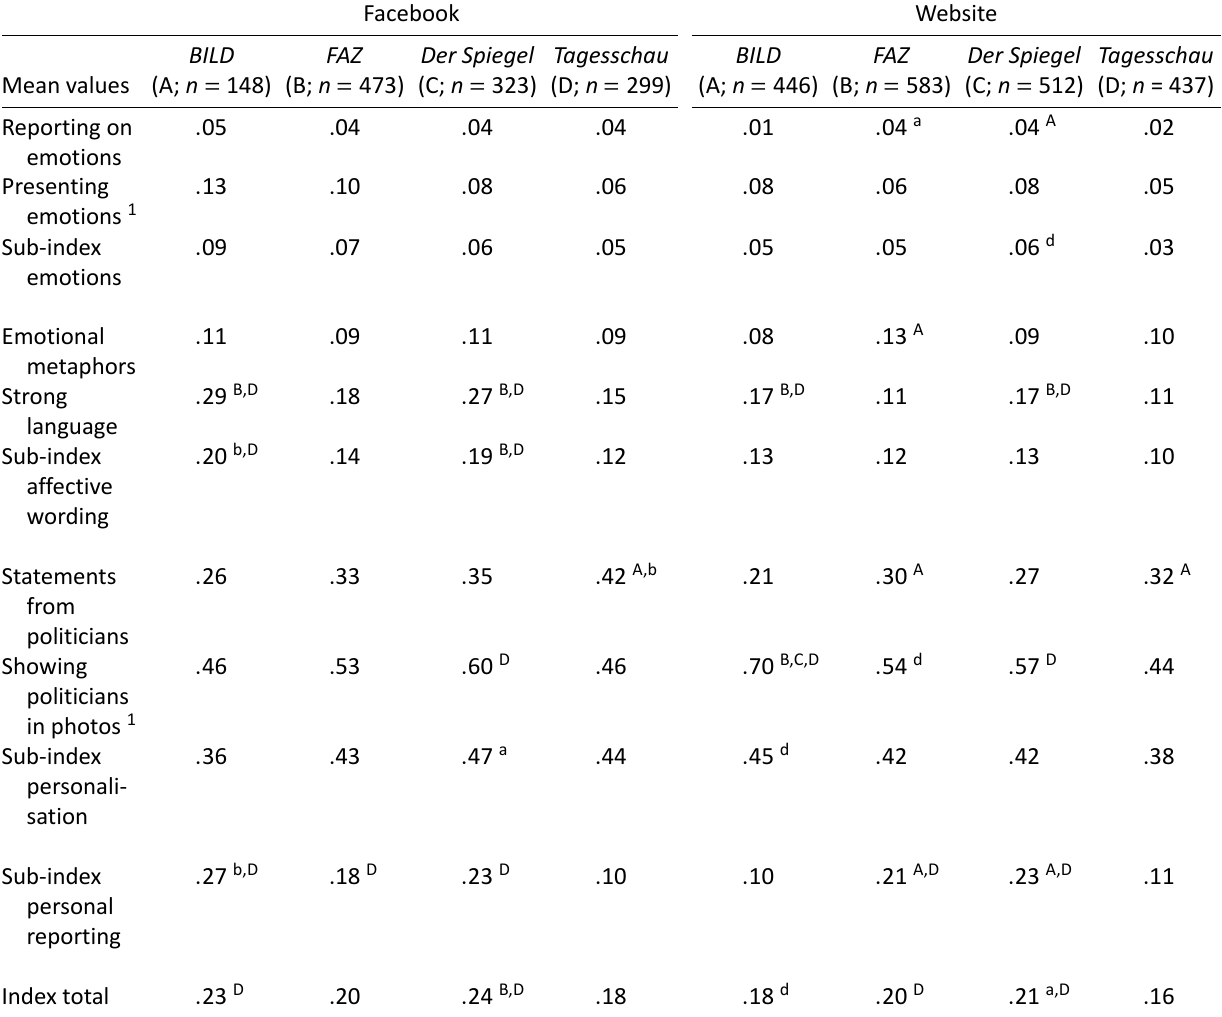
Table 4. Comparison of Facebook posts and website teasers regarding news